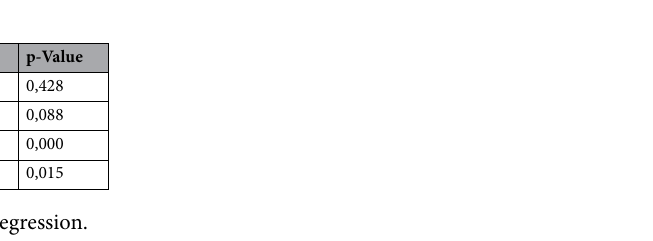
hazards regression was used for evaluating the independent prognostic factors of age, sex, iron content, and tumor stage (pathological) on survival of patients with lung adenocarcinoma (n = 49) (Table 2) and the signifi- cance of the model was confirmed by Omnibus testing (p = 0.01). Patient sex (p = 0.428) or age (p = 0.088) did not significantly affect patient outcome. As expected, the division of pathological tumor stages (pStage) into two groups (stage I/II and stage III/IV) showed a significant effect on patient survival (p < 0.0001) (Hazard ratio (HR) = 4.999, 95% CI 2.200; 11.360). Importantly, iron was an additional independent predictor of patient out- come (p = 0.015), whereby patients with iron-positive tumors showed a better outcome compared to patients with iron-negative tumors (HR = 0.298, 95% CI 0.112; 0.790).